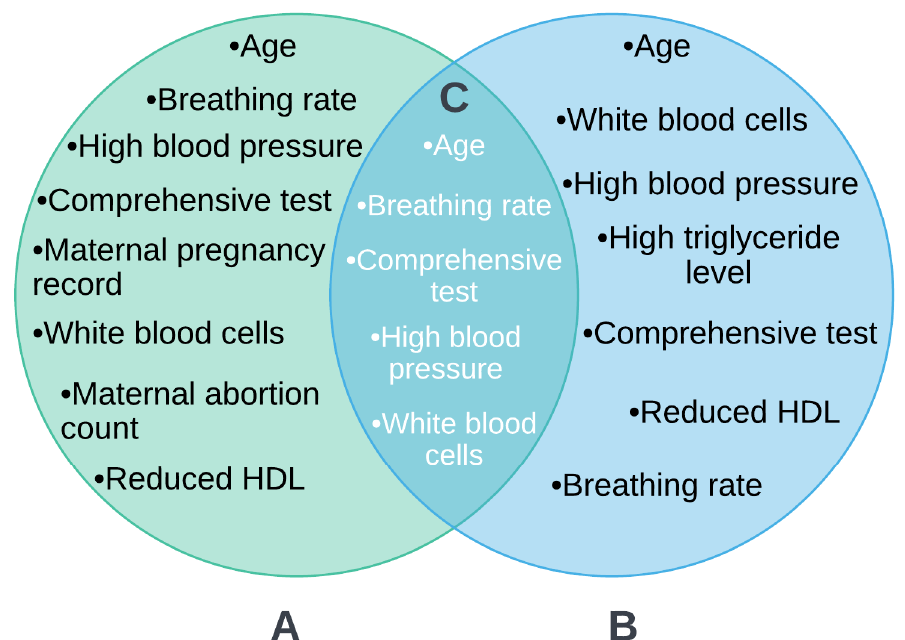
Figure 6. An analysis of the intersection of the most important metabolic indicators found via metaheuristics algorithms and SHAP. ( A ) Shows a set of common selected features by ACO, GA, PSO, FA, and BA algorithms as the most important indicators. ( B ) Shows as set of classified features as the highest discriminative power for prediction by SHAP values. ( C ) Shows an intersection for the final most informative features between metaheuristic algorithms and SHAP.